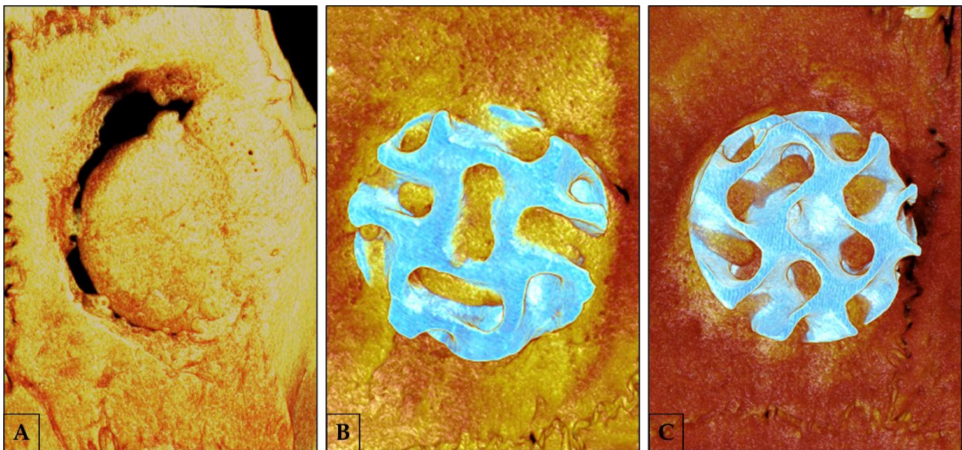
Figure 3. 3D images obtained by CTVox software representing the bone formation of Auto/PG, TCP/PG, and HA/PG groups. ( A ): Auto/PG group; ( B ): TCP/PG group; ( C ): HA/PG